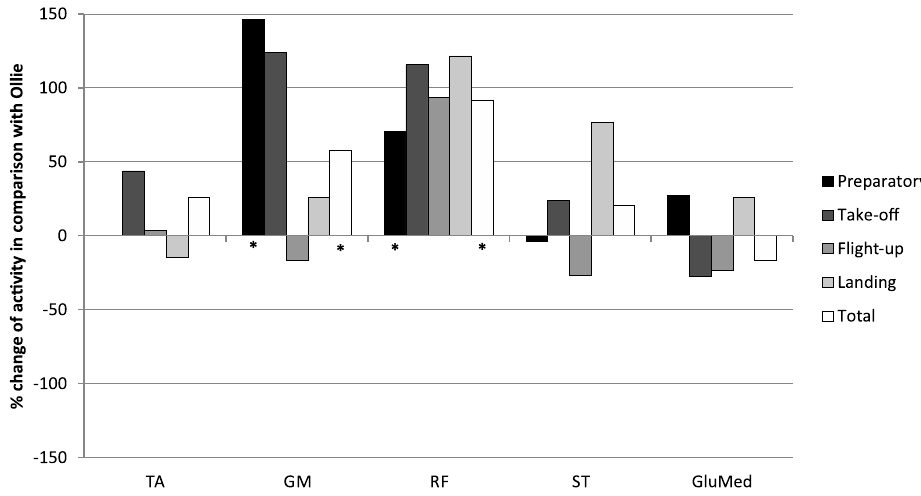
Figure 2. Back lower limb muscle activity during switchstance Ollie in comparison with Ollie. TA = tibialis anterior, GM = gastrocnemius medialis, RF = rectus femoris, ST = semitendinosus, GluMed = gluteus medius. * p <